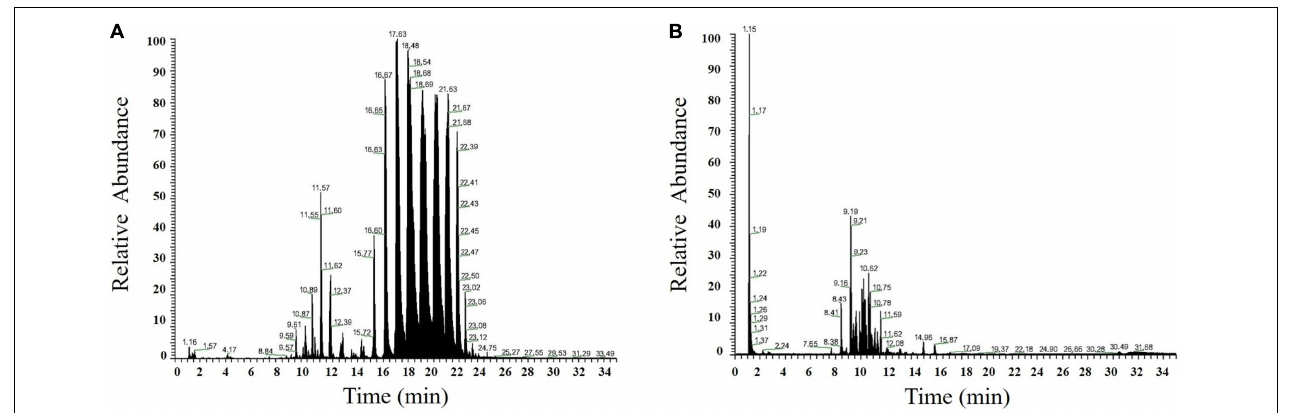
FIGURE 2 | Chromatogram in ESI-positive (A) and ESI-negative ion modes (B) of